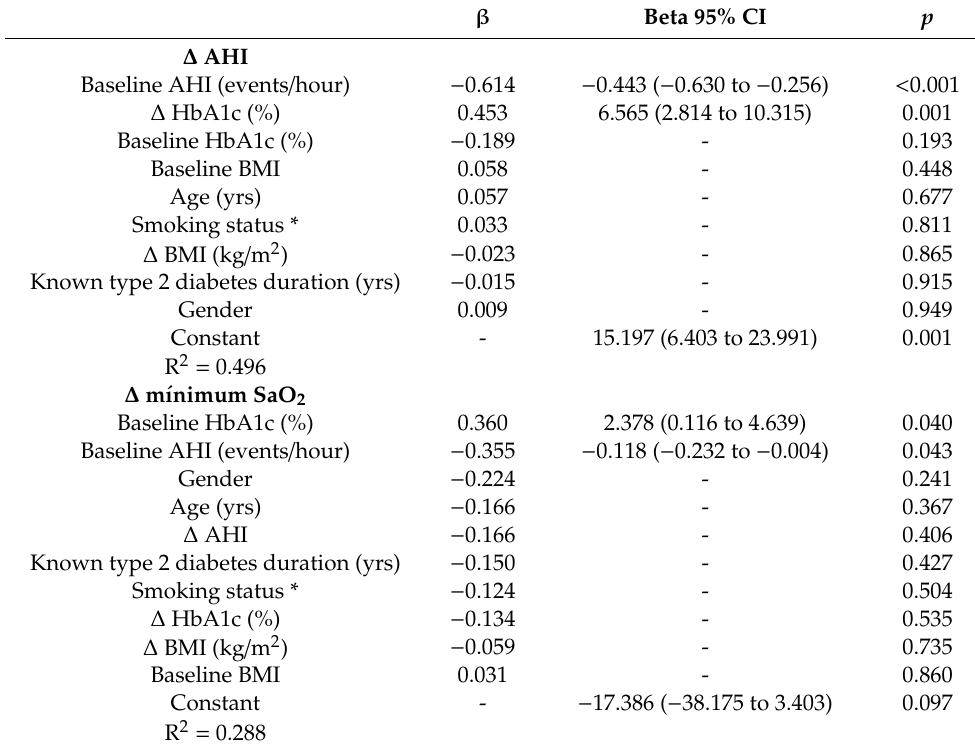
Table 2. Variables independently related to changes in the apnea–hypopnea index and minimum SaO 2 in the multiple regression analysis (stepwise